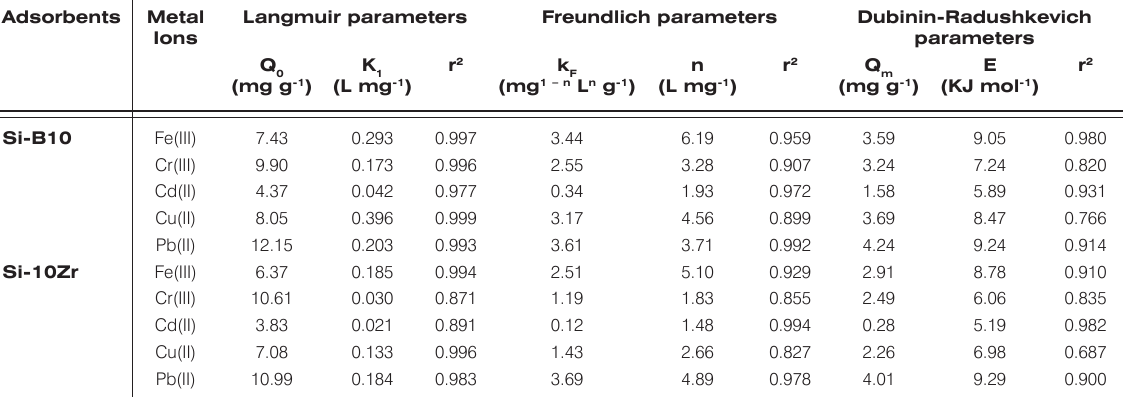
Table 2. Isotherm constants for adsorption of metal ions on Si-10B and Si-10Zr. Adsorbents Metal Langmuir parameters Freundlich parameters Dubinin-Radushkevich Ions